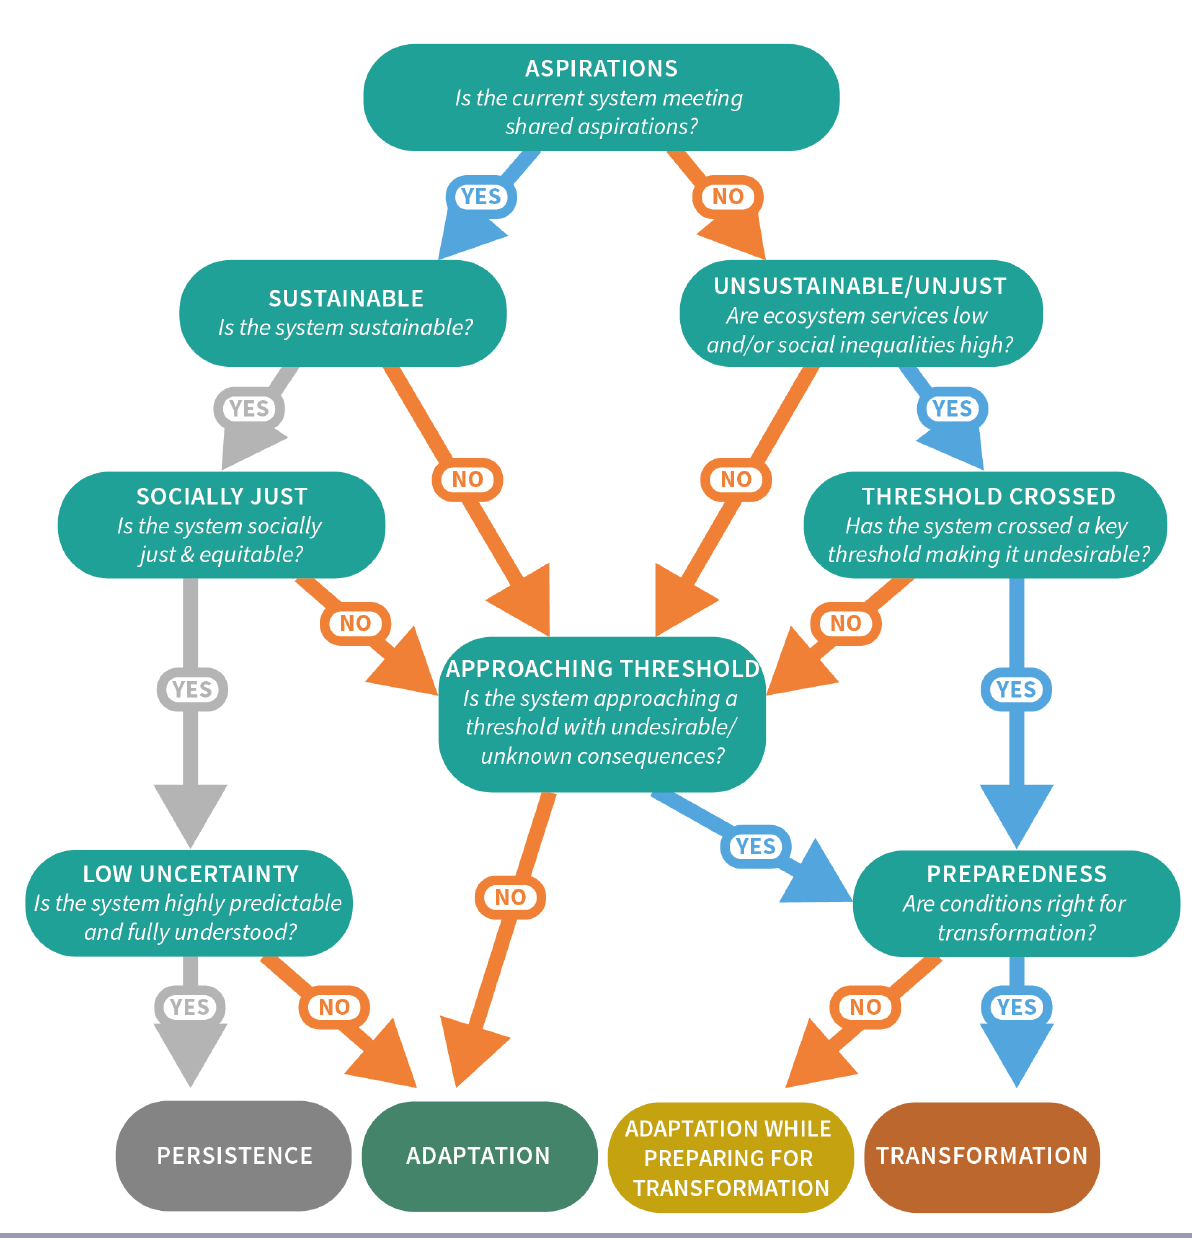
Fig. 2. Decision tree to determine what level of change will be required in a social-ecological system. Wayfinder distinguishes between adaptive and transformative change as two broad types of strategies for navigating different trajectories. Adaptation reflects gradual improvements on the current development trajectory, whereas transformation reflects a more radical form of change in which the system embarks on a new, substantively different development trajectory. Illustration: E.